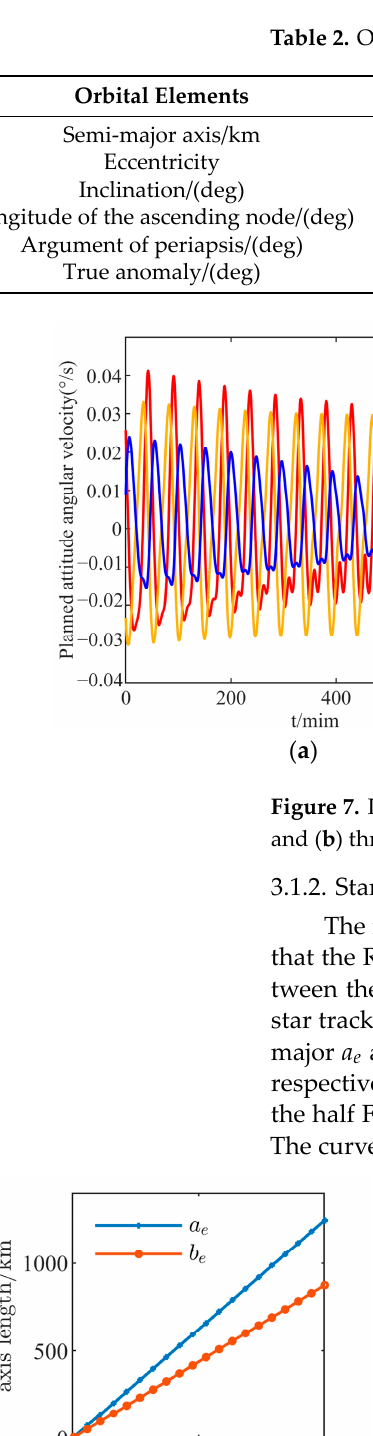
Figure 8. The curves of the major axes a e and b e : ( a ) curves with the increase in the detection distance d ; ( b ) curves with the increase in half FOV θ fov /2 ; and ( c ) curves with the increase in angle α . Apparently, the curves of